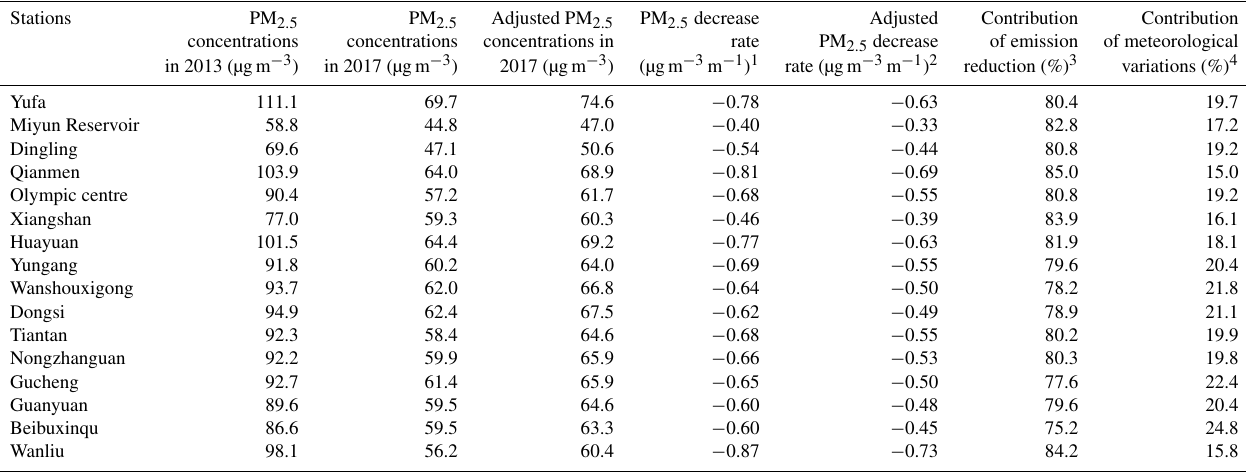
Table 5. Estimated relative contribution of emission reduction and meteorological variations to PM 2 . 5 reduction in Beijing from 2013 to 2017 using KZ filter.